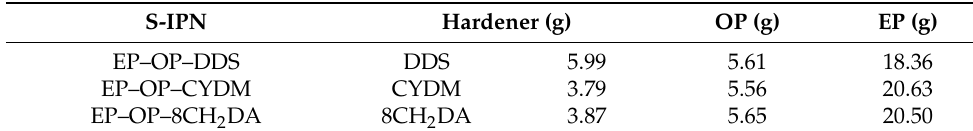
Table 1. Composition of the S–IPNs.